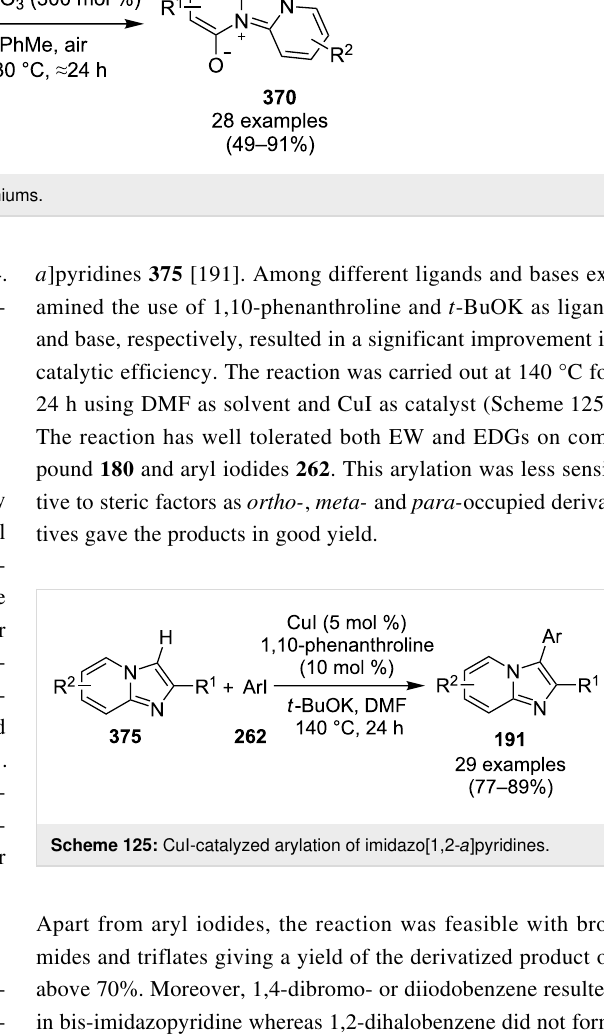
Scheme 123: Two-component reaction for synthesizing imidazodipyridiniums.